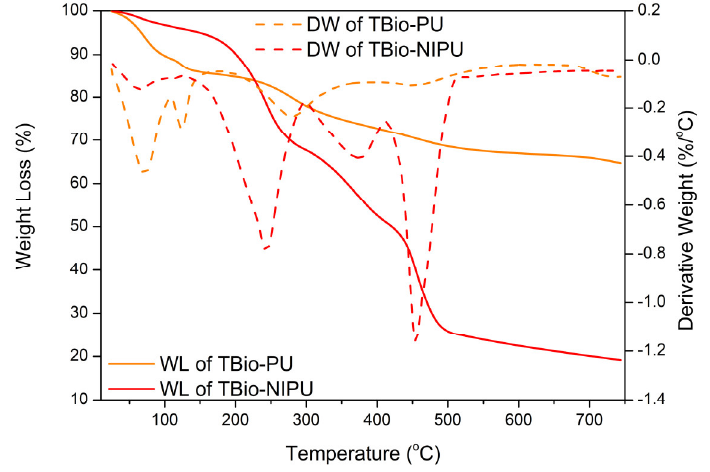
Figure 6. TGA/DTG curves of tannin-based Bio-PU and Bio-NIPU.